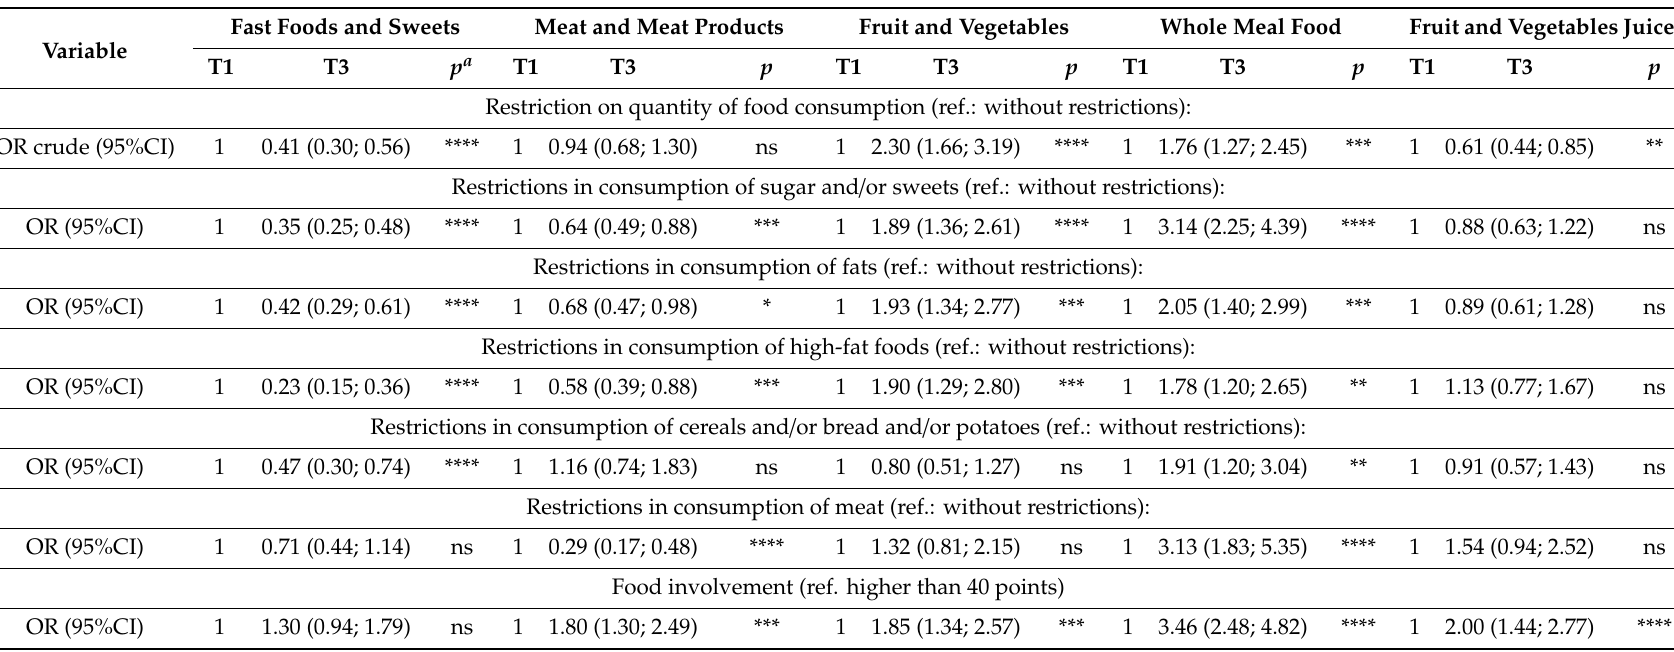
Table 4. Odds ratio (OR (95% confidence interval (CI)) of dietary patterns by eating restrictions in the sample. Fast Foods and Sweets Meat and Meat Products Fruit and Vegetables Whole Meal Food Fruit and Vegetables Variable